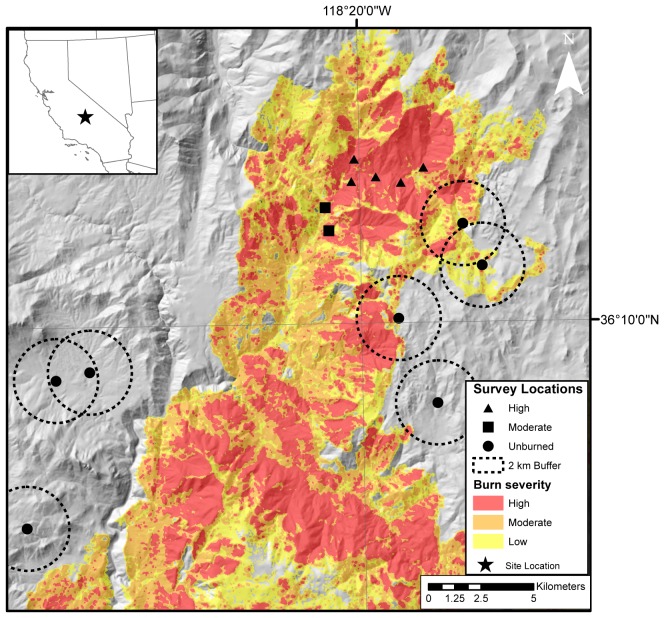
Study area.Map of sampled portion of the 2002 McNally Fire (southern Sierra Nevada mountains, California, USA) with topography and the extent of low-, moderate-, and high-severity fire damaged areas with study sites identified by severity type. Dashed lines represent 2 km radii buffers used to quantify the area of high-severity fire damage surrounding each unburned site.